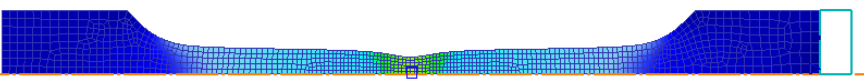
Figure 6. Neck formation as predicted by FEM.